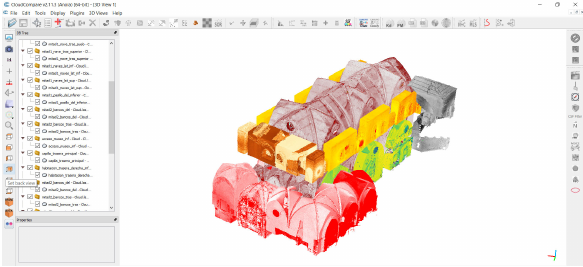
Figure 3. Segmentation by architectural element of the raw point cloud collected inside the Santa Mar´ıa church (Tobed, Spain).